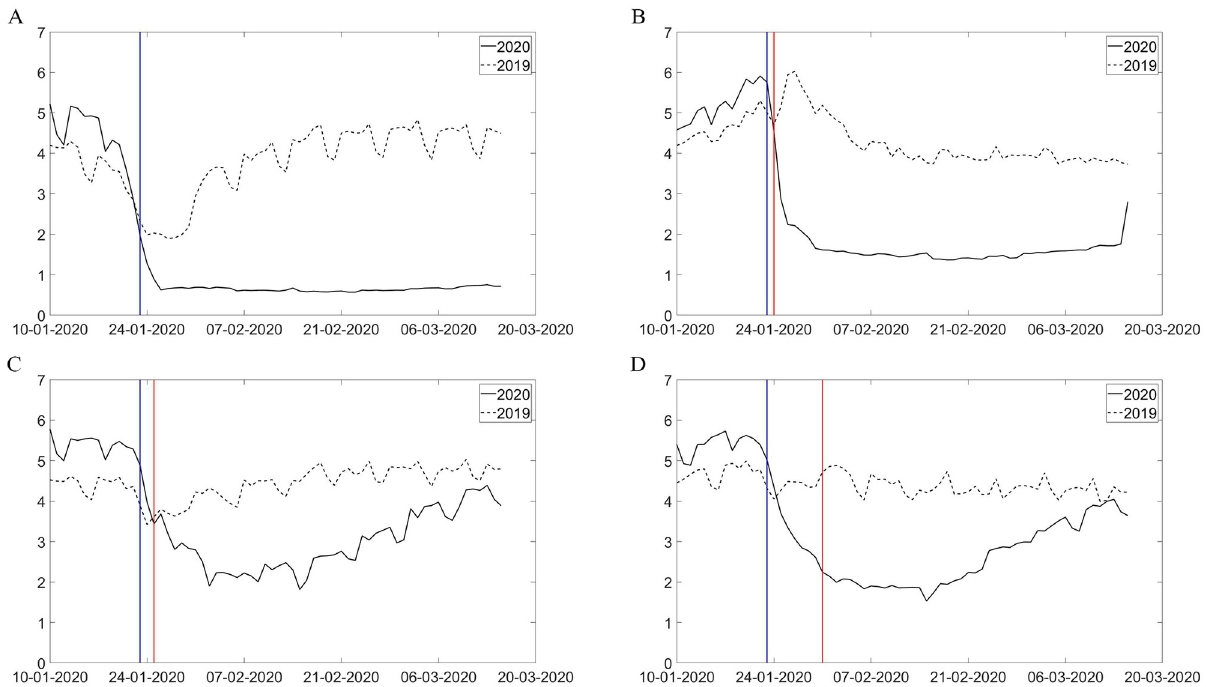
Fig 6. Within-city mobility. These graphs plot daily variations in within-city mobility in Wuhan(a), Huanggang(b), Qinghuangdao(c) and Chongqing (d) in 2019 and 2020. Blue Line indicates the date of Wuhan lockdown (Jan 23,2020) and red line indicates the date of each city’s own lockdown.